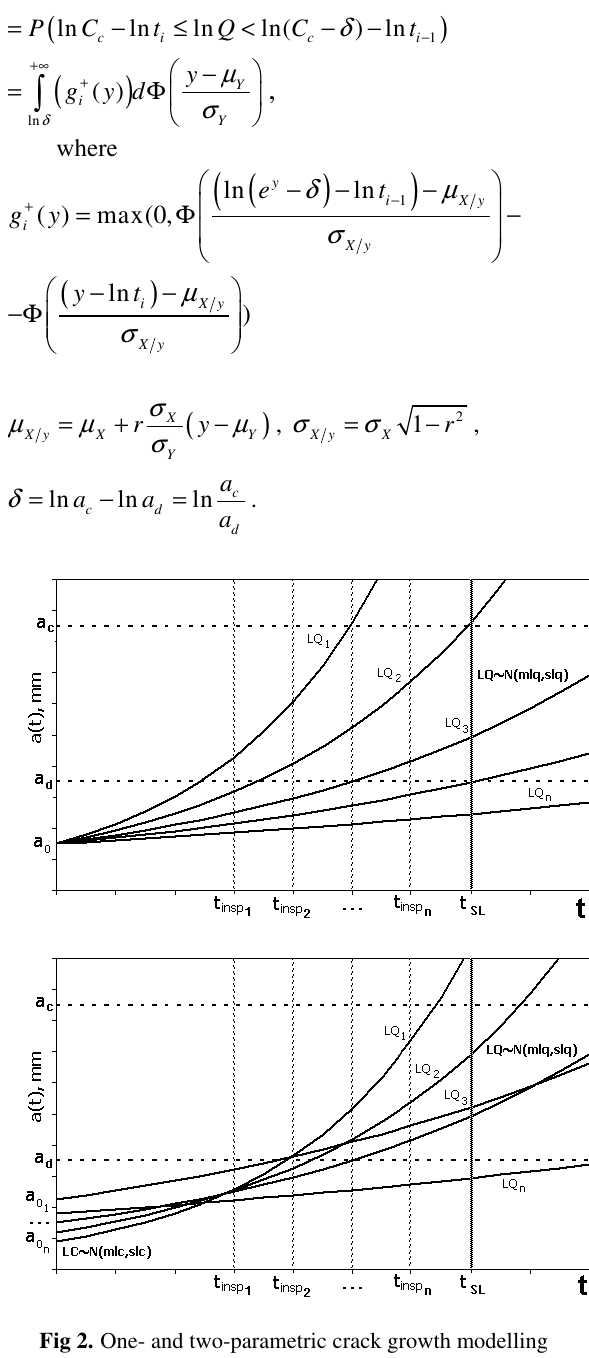
Fig 2. One- and two-parametric crack growth modelling